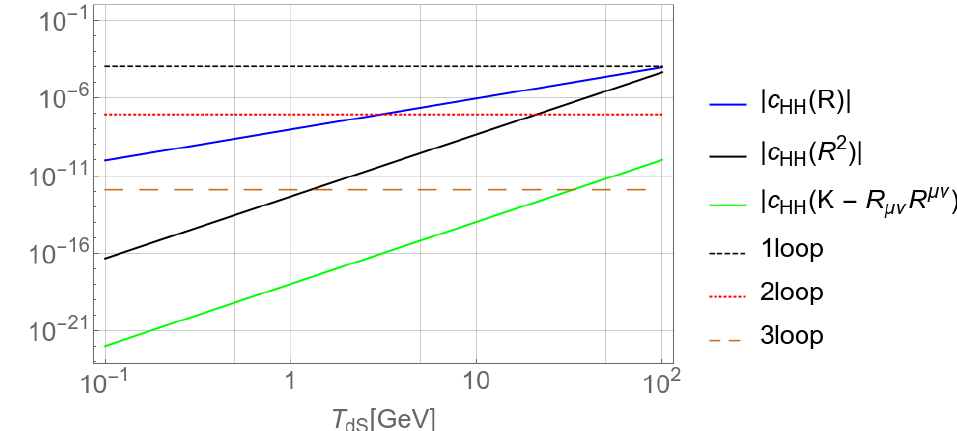
Figure 6 . The contribution of the gravity induced part of the c HH coe(cid:14)cient to the Higgs qaurtic coupling in the de Sitter like FLRW background. The c HH is given by (3.23). Loops prefactors are n +1 given by the formula nloop= (cid:21) and T dS is the temperature of the de Sitter spacetime. For H (16 (cid:25) 2 ) n the plot we chose (cid:21) HX = 0 : 25, (cid:21) H = 0 : 13, m X = 10TeV and (cid:24) X = 10. The plot was made in the double logarithmic